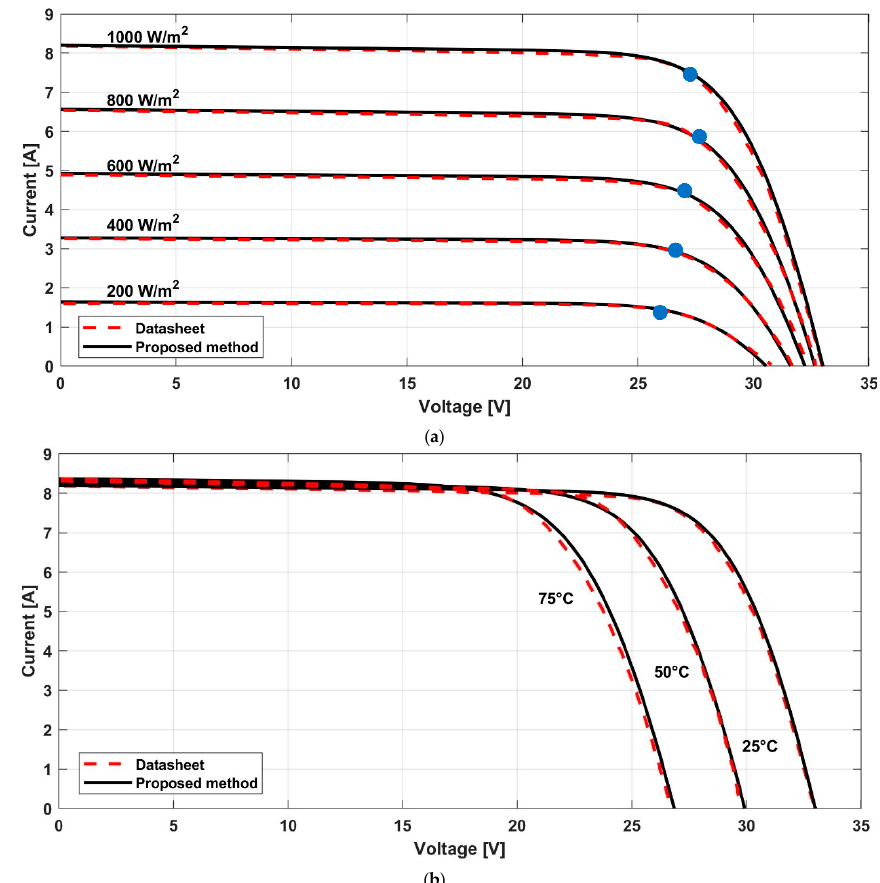
Figure 7. Comparison between the estimation and measured data of solar irradiance variation with the circled MPP point ( a ) and temperature variation ( b ) of the proposed method using Silva’s model [47].